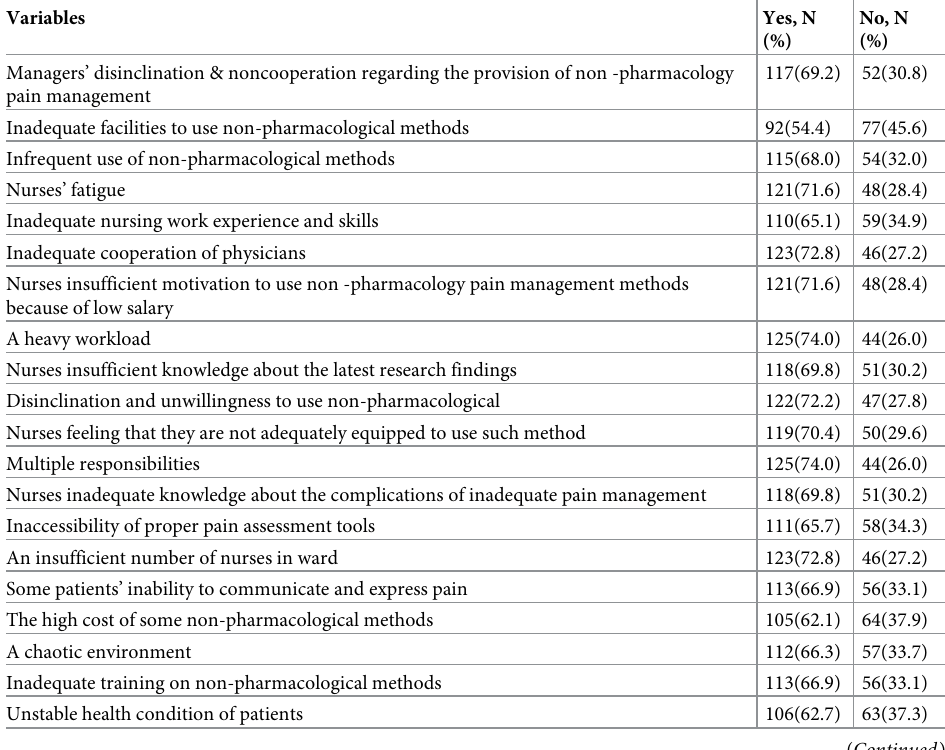
Table 3. Barriers to the use of non-pharmacological pain management methods among nurses working in Debre Tabor Comprehensive Specialized Hospital, Ethiopia, 2020.